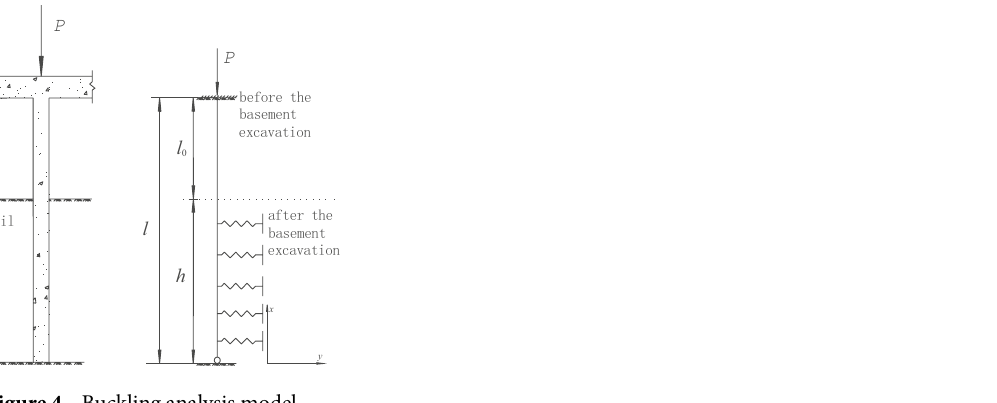
Buckling stability equation